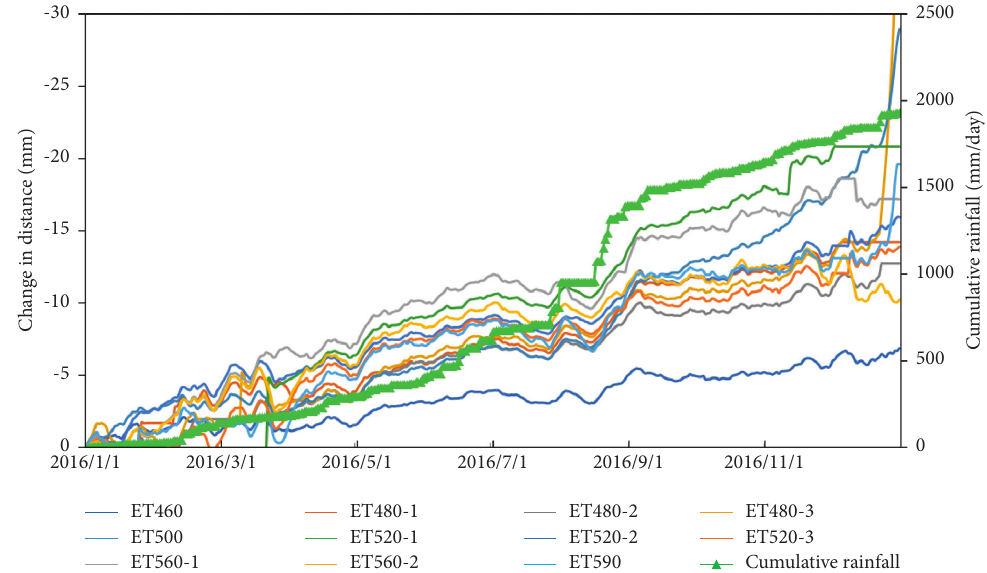
Figure 18: The comparison between cumulative rainfall and measured change in distance.